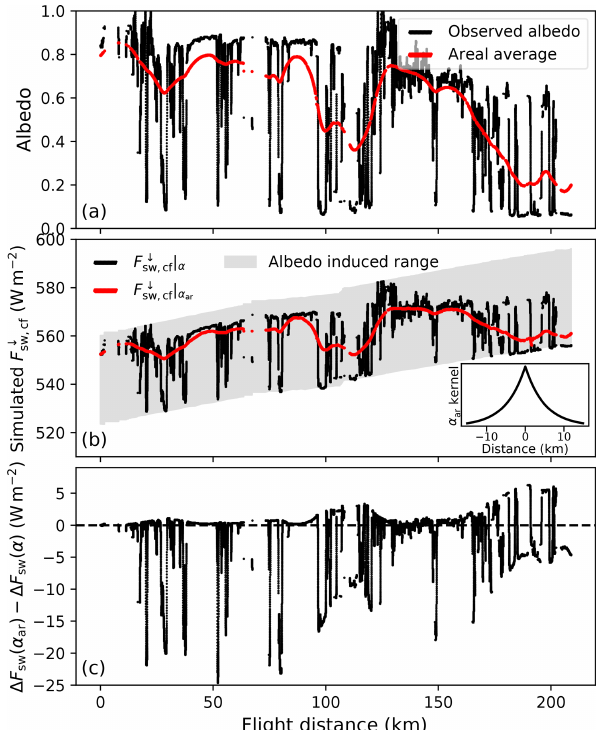
Figure 7. Time series (covered distance) of measured broadband surface albedo (black) (a) and simulated F level flight track during 23 May 2017. The red line in (a) shows the areally averaged albedo using the kernel embedded in (b) . (b) The gray area illustrates the potential variability in F albedo changes. The black and red scatter plots show the F ↓ | α and F , respectively. (c) Difference in shortwave CRF esti- sw,cf ar mate between (cid:49)F sw (α ar ) and (cid:49)F sw (α) . by a Laplace